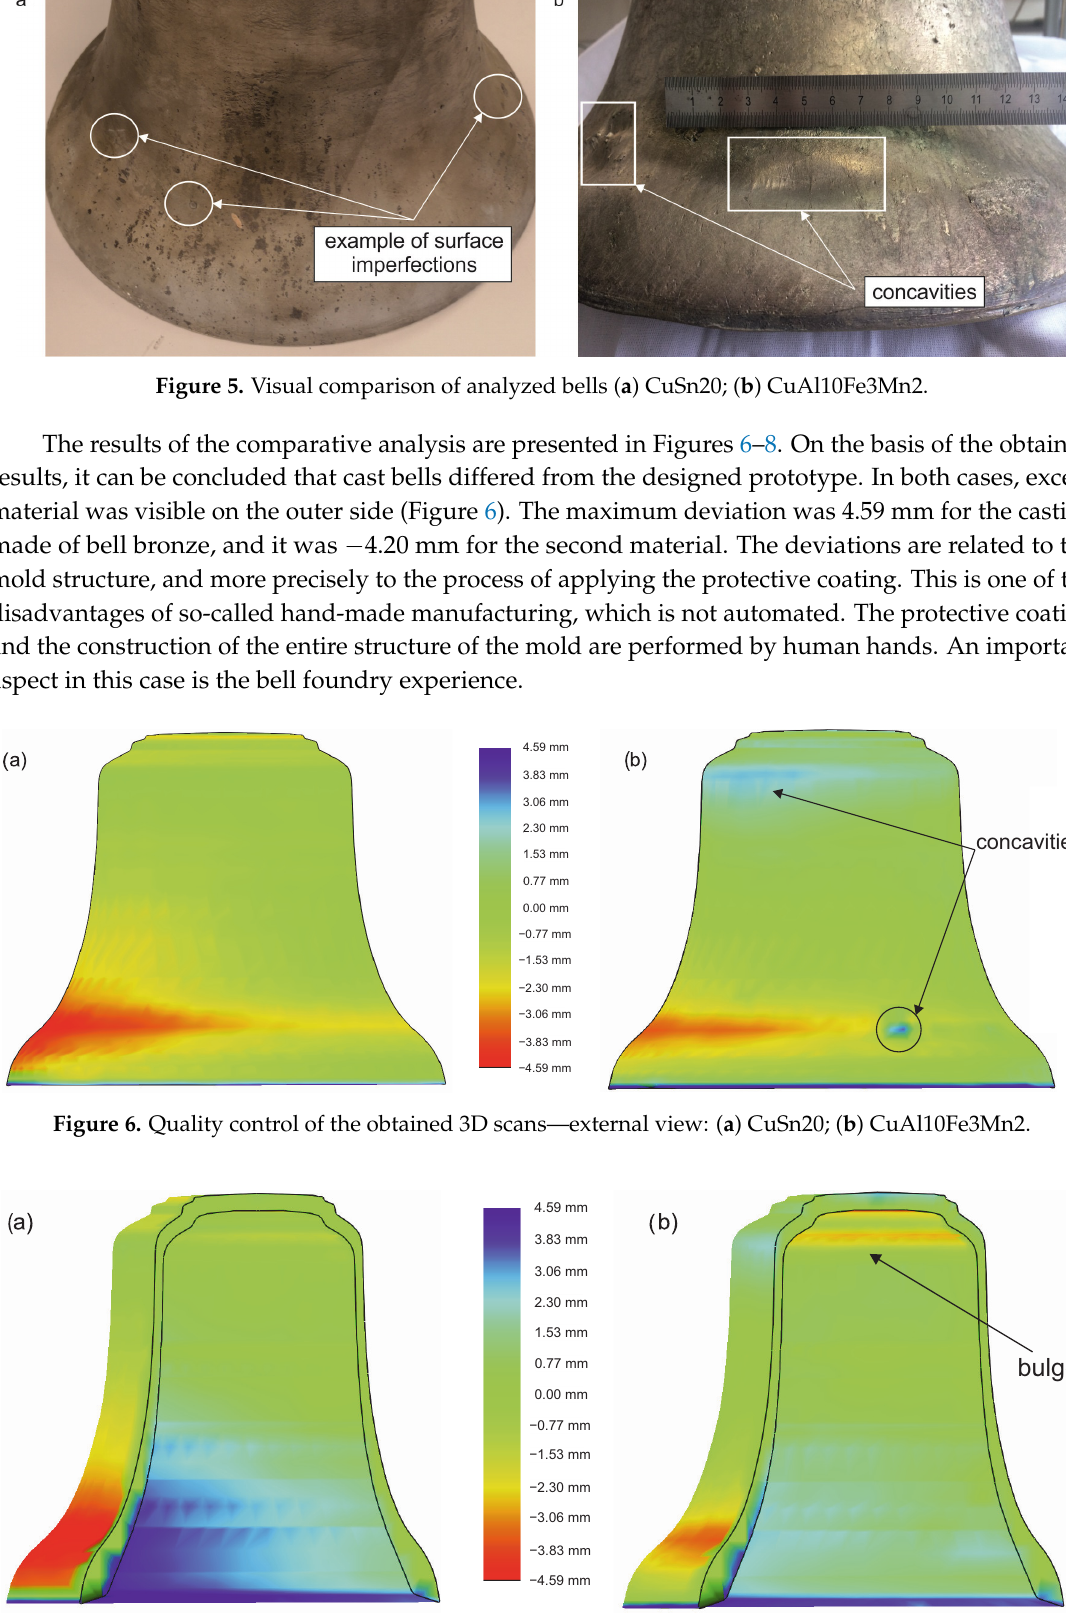
Figure 7. Quality control of the obtained 3D scans—sectional view: ( a ) CuSn20; ( b )